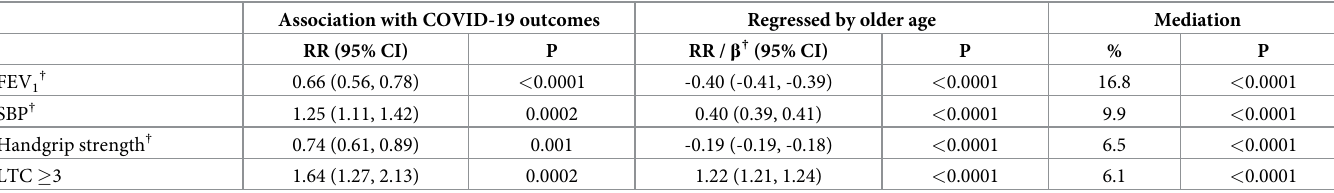
Table 2. Potential mediators of the association between age � 75 years and COVID-19 mortality. Association with COVID-19